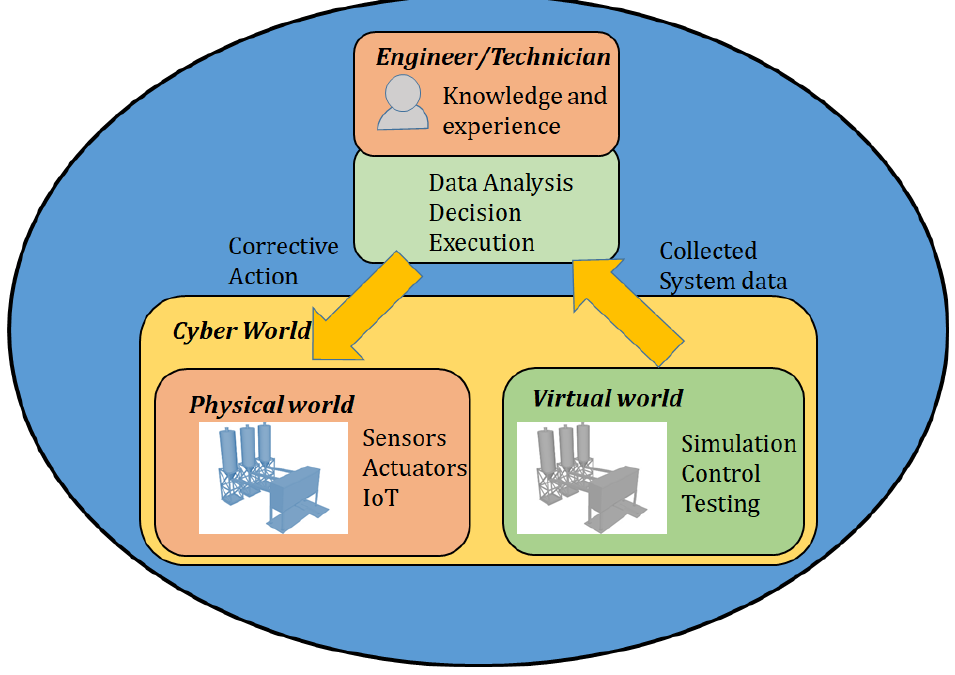
Figure 2. Original Digital Triplet concept